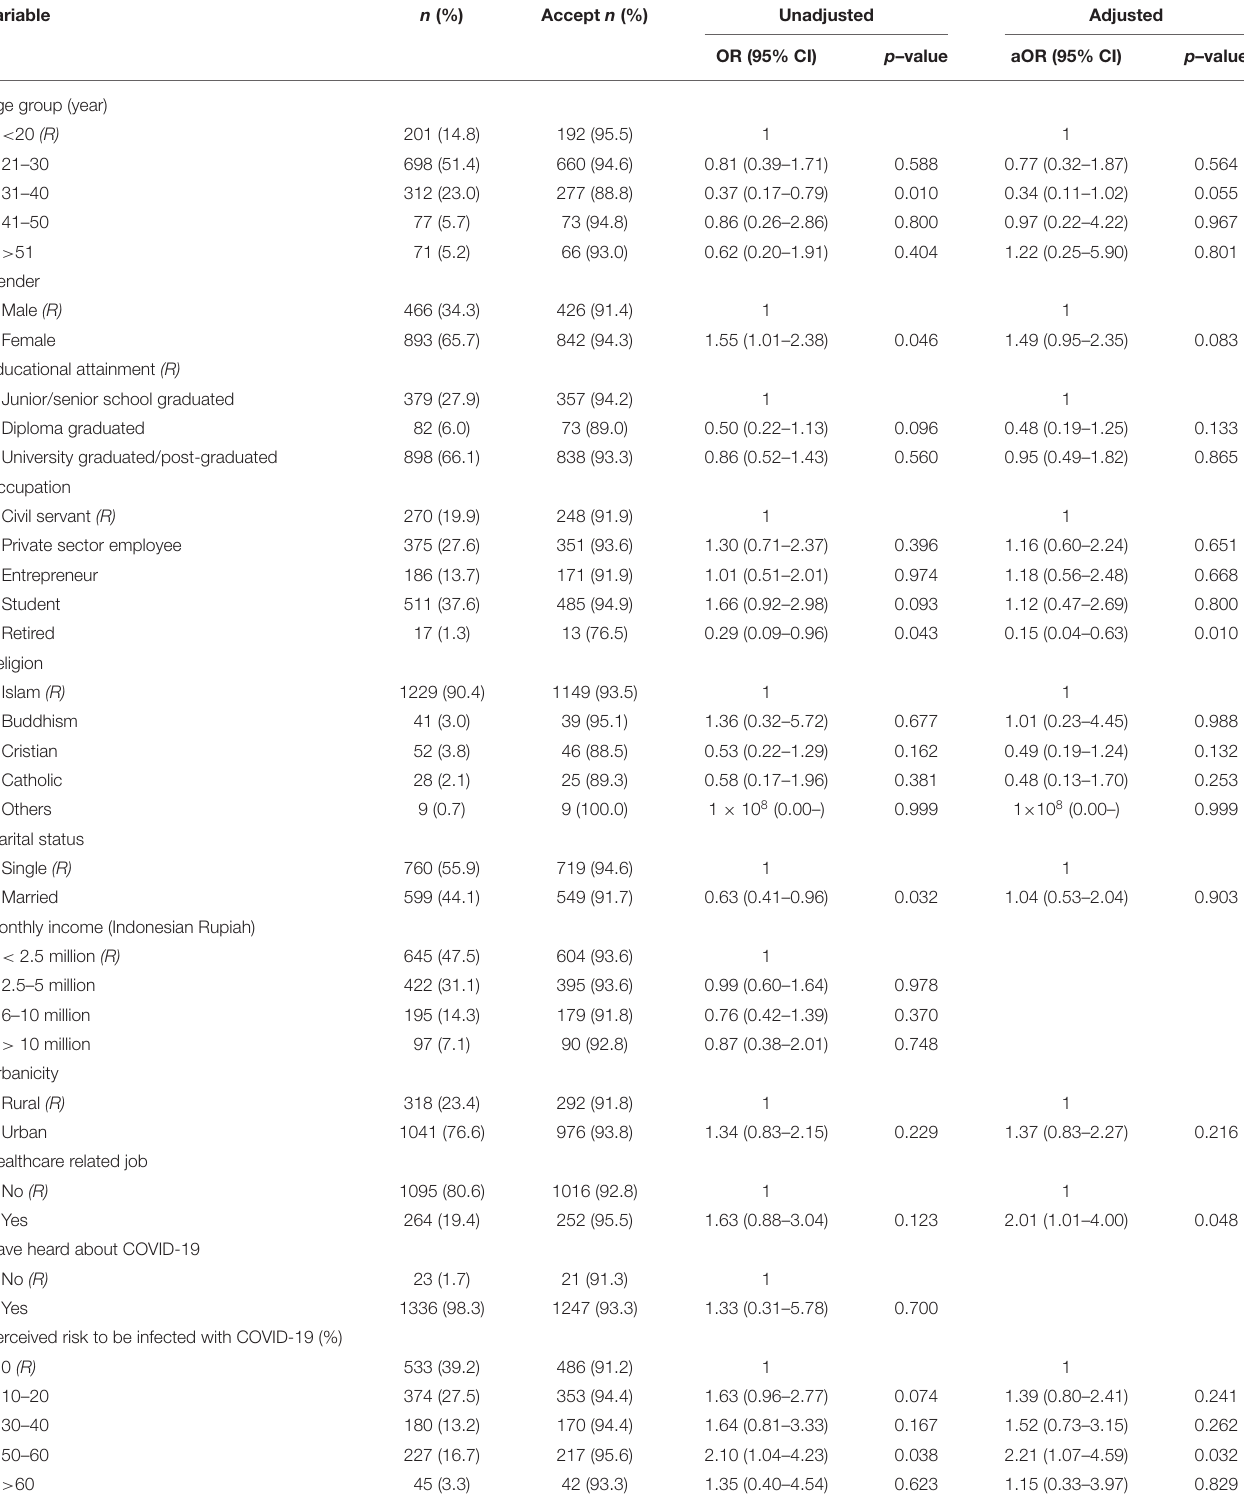
TABLE 1 | Unadjusted and adjusted logistic regression analyses showing factors associated with acceptance of a COVID-19 vaccine in Indonesia, 95% effectiveness ( n = 1,359).